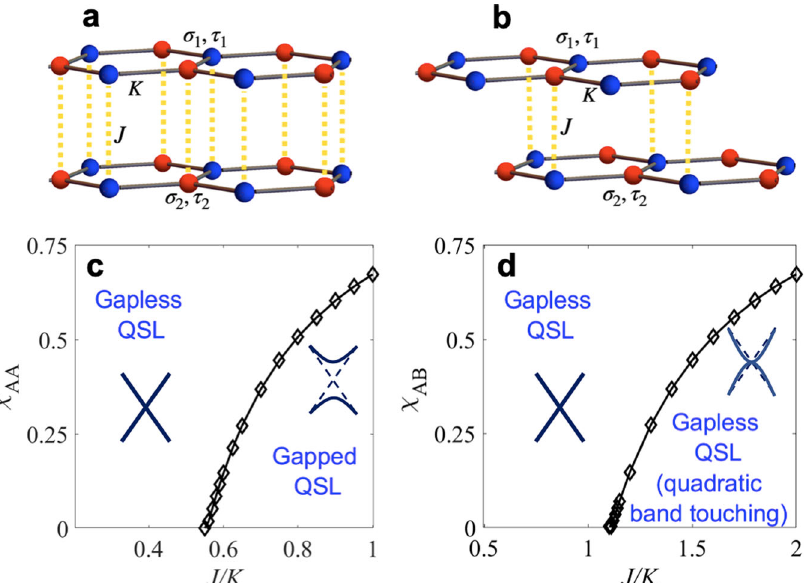
Fig. 1 Yao-Lee bilayer without twisting. Illustration of the model for ( a ) AA and ( b ) AB stacking patterns. K and J are the intra-layer Kitaev and inter-layer Heisenberg exchange terms, respectively. ( c ) Effective inter-layer hybridization for AA stacking. Finite χ of inter-layer singlets and leads to gapped itinerant Majorana fermions. ( d ) Same for AB stacking, leading to quadratic band